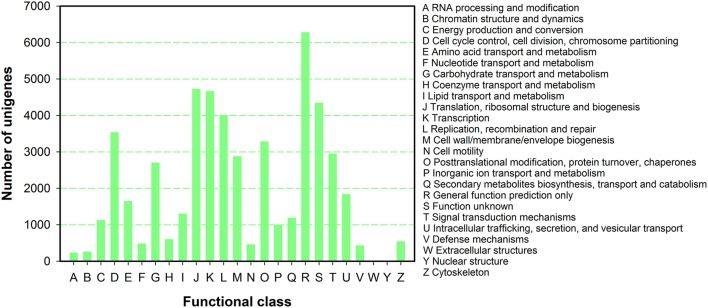
COG function classification of P. ternata unigenes.